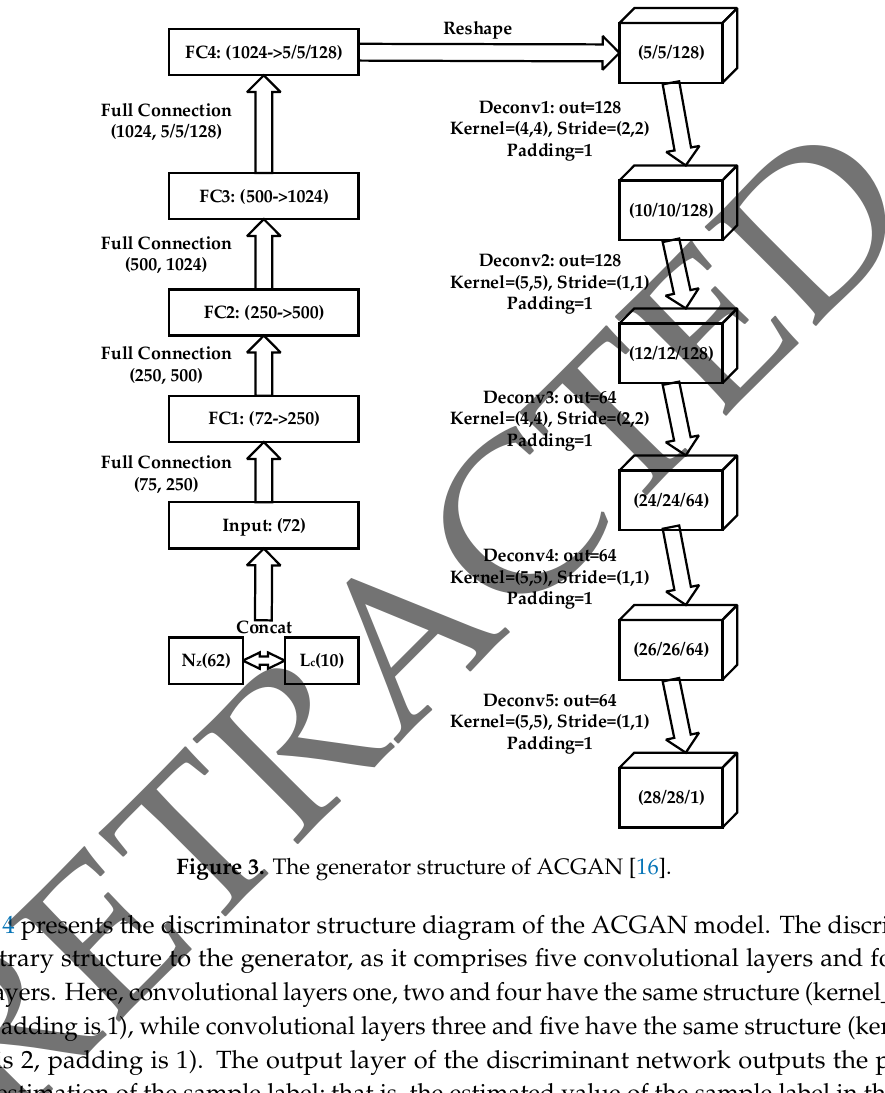
Figure 3. The generator structure of ACGAN [16].